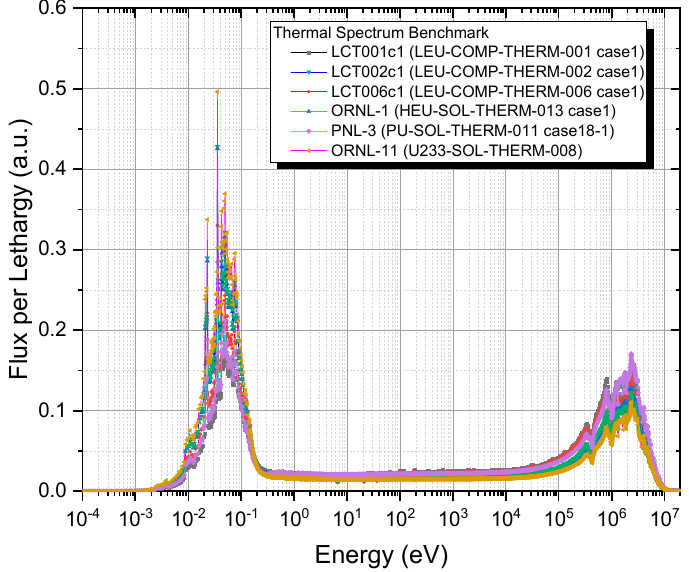
Figure 3. Spectra of example thermal benchmark problems. Table 2. A list of selected International Criticality Safety Benchmark Problems.